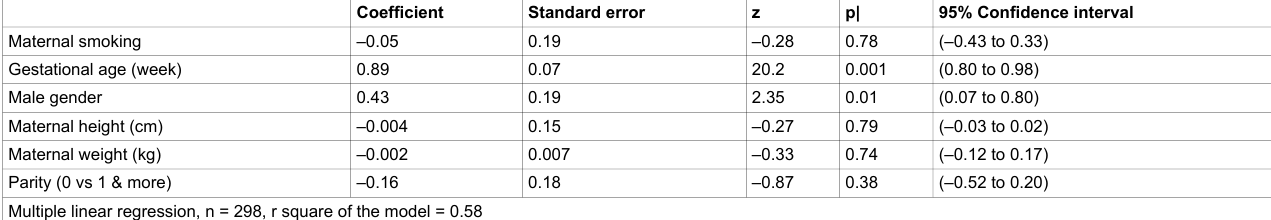
Table Va: The impact of maternal smoking on the head circumference of very preterm neonates. Coefficient